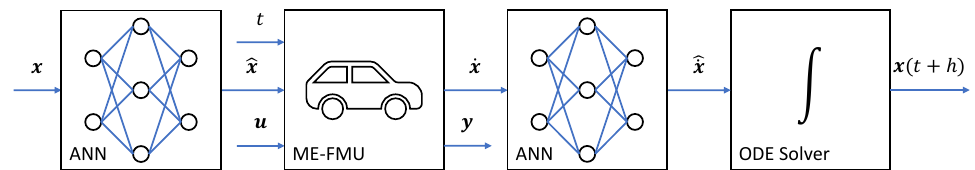
Figure 3. Topology of an ME-NeuralFMU (example) consisting of two feed-forward ANNs, an ME-FMU and a numerical ODE solver. The current system state x is passed to a (state) ANN. A manipulated system state ˆ x is calculated and passed to the ME-FMU. There, the system state derivative ˙ x is computed and manipulated by another (derivative) ANN into the changed system state derivative ˆ˙ x , which is finally integrated into the next system state x ( t + h ) by the ODE solver with the time step size h . Additionally, the FMU’s input u , output y or parameters (not shown) can be connected to the